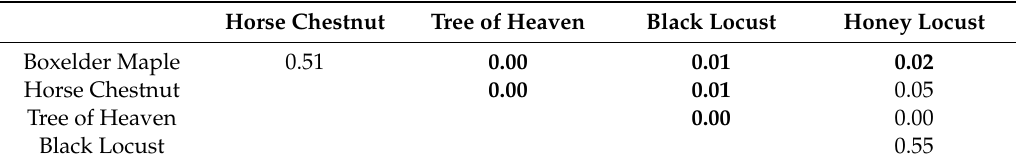
Table 5. Statistical di ff erence of the routing surface quality grades between di ff erent tree species expressed by the p -value of the ANOVA analysis. The values in bold indicate a significant di ff erence.